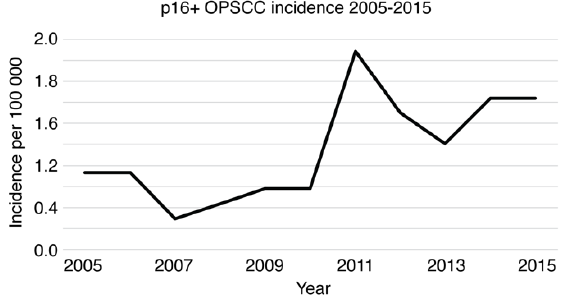
Figure 7. p16-positive OPSCC incidence in PV-TMA from 2005–2015.